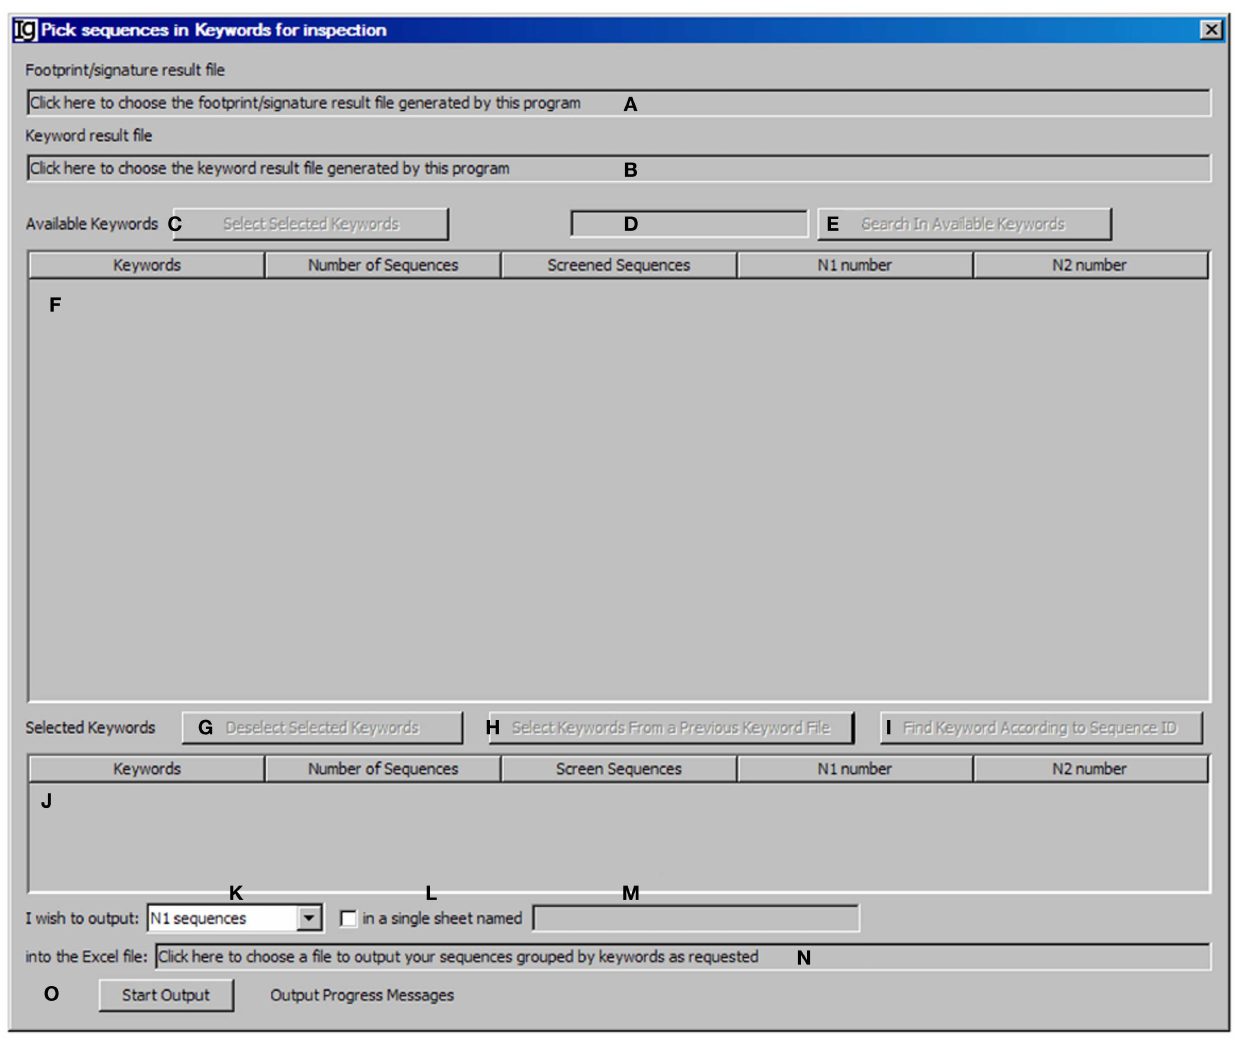
FIGURE 7 |The keyword group picker . Diagram shows the interface of the Keyword Group Picker . (A) Textbox to select the footprint analysis result file. (B) Textbox to select the keyword analysis result file. (C) Button to move selected rows from (F) to (J) . (D) Textbox for entering search string to locate keywords in (F) . (E) Button to start locating keywords containing string in (D) . (F) Window area containing contents of the keyword analysis result file. (G) Button to move selected rows from (J) to (F) . (H) Button to select a